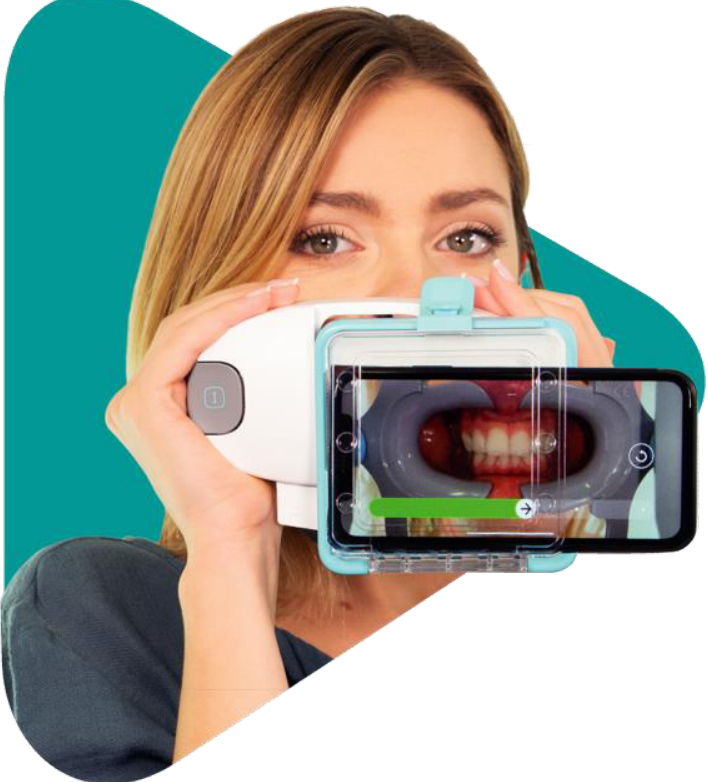
Figure 12. Dental Monitoring system (Dental Mind, Paris,